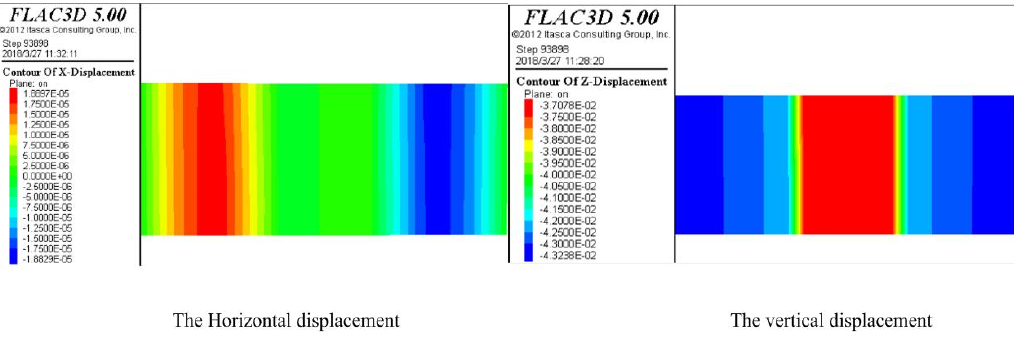
Figure 14. The horizontal and vertical displacement nephogram.